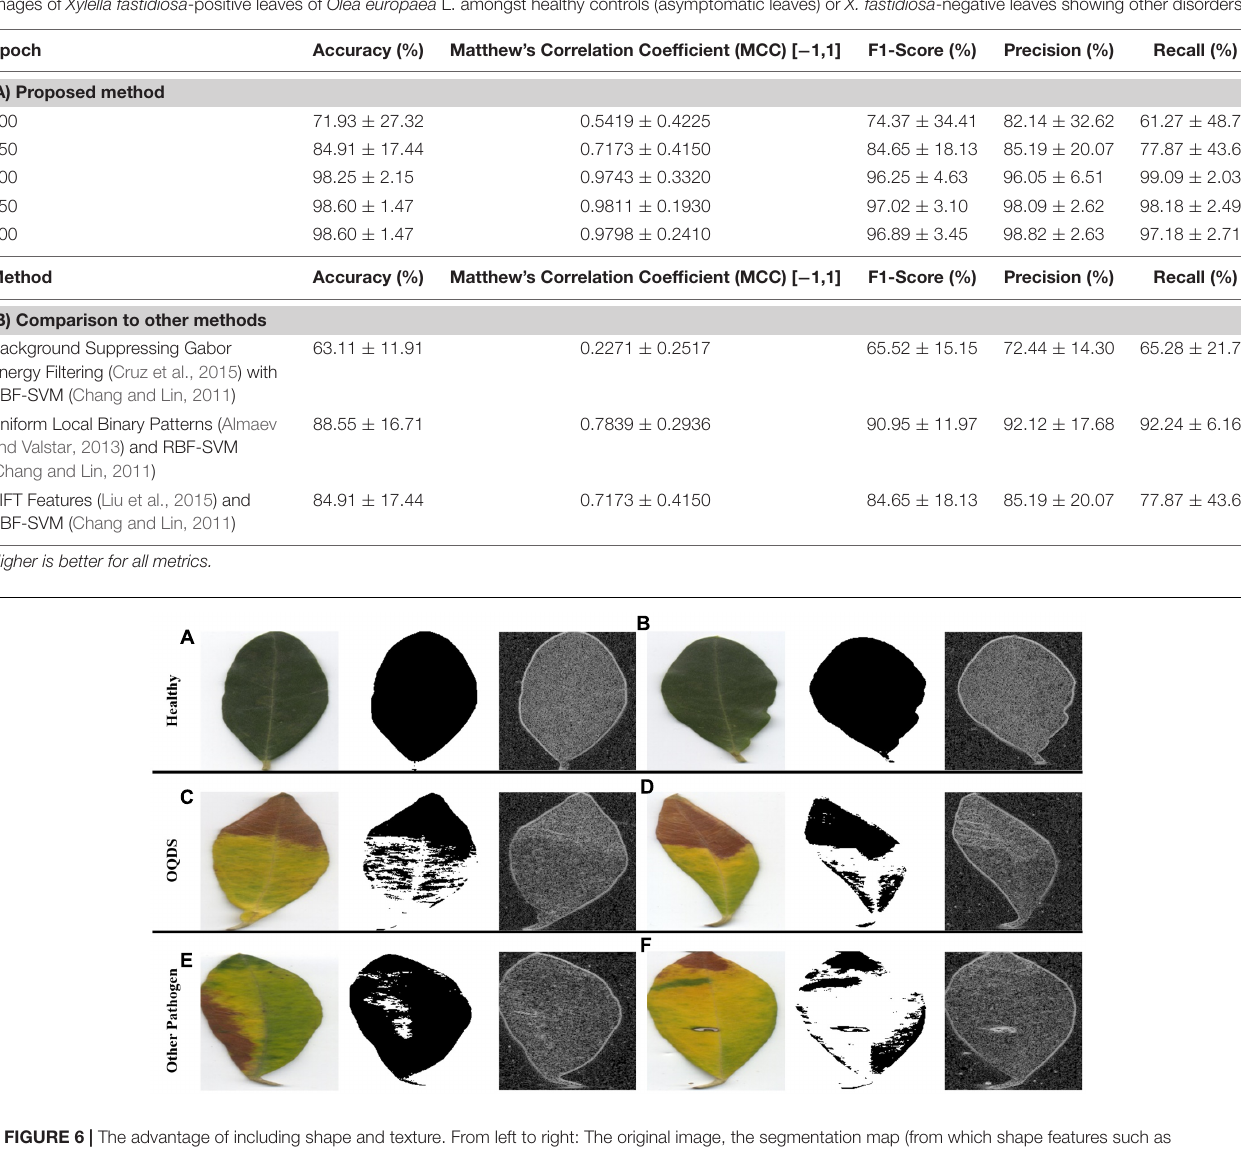
FIGURE 6 | The advantage of including shape and texture. From left to right: The original image, the segmentation map (from which shape features such as moments are extracted), and the edge map. (A,B) The healthy leaves (asymptomatic), (C,D) OQDS leaves, and (E,F) non-OQDS leaves. Healthy leaves do not have any notable features in either the segmentation or edge maps. OQDS results in a more yellow leaf causing a distinct shape in the segmentation map, and note the subtle lines in the dead area of the leaf in (D) . While other pathogens/disorders cause yellow leaves, it does not occur as orderly as leaf scorch, and dead areas do not have the distinctive subtle lines as in (D) . Note that these images have been resized to 256 × 256 as a part of Step (3) in Figure 2